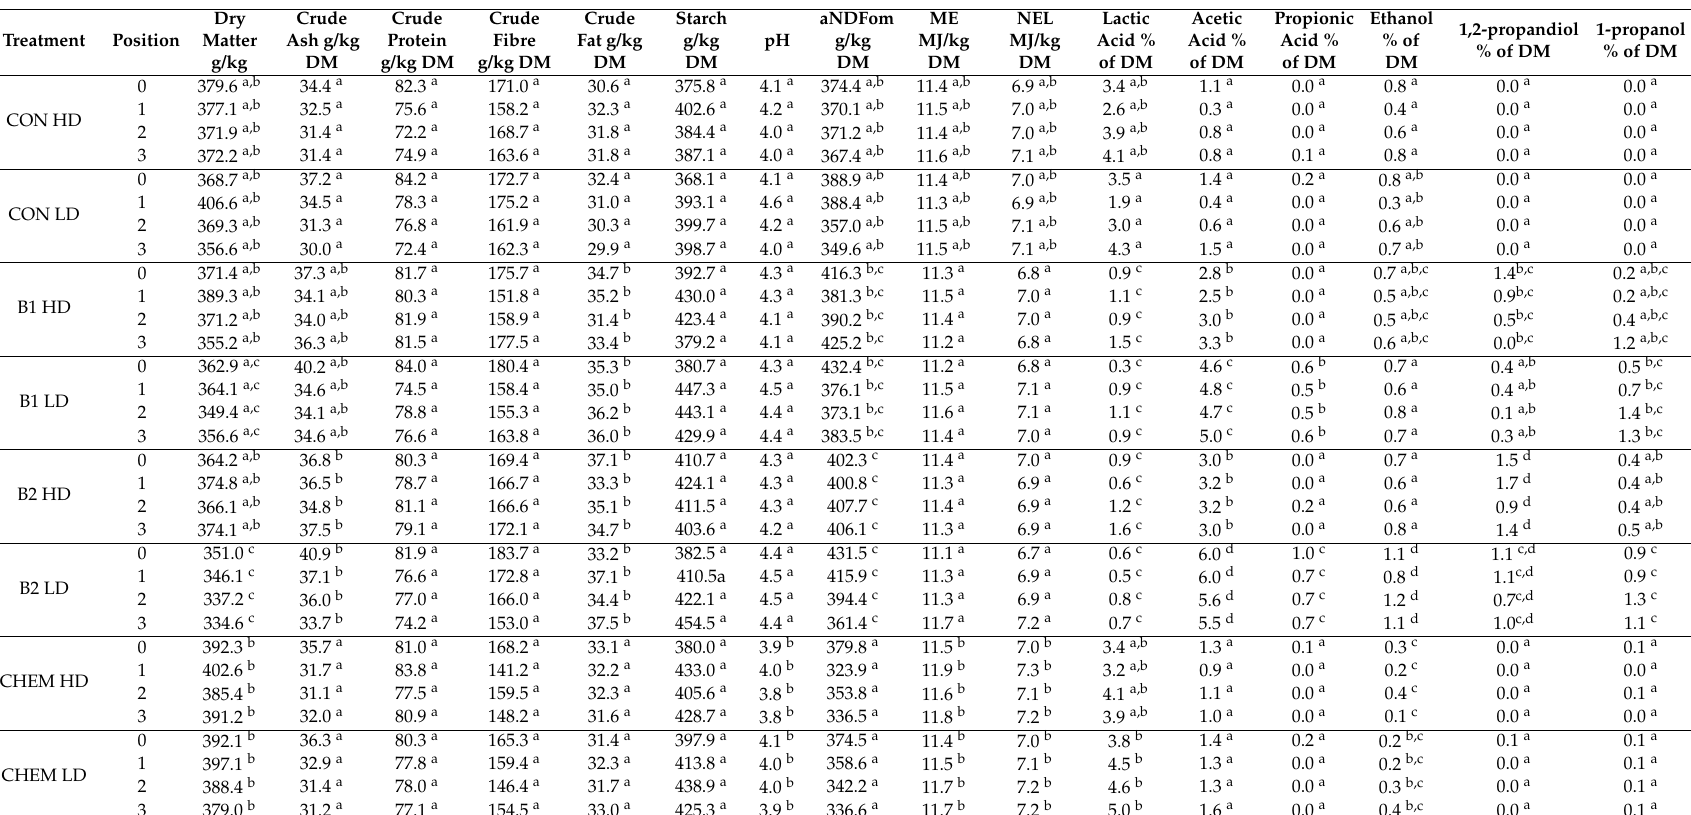
Table 1. Analytical state of maize silage samples from the buckets before (sample 0) and after reheating for silage originating from three different sampling depth as described in Jungbluth et al. (2016) (samples 2–4); DM = dry matter, aNDFom = neutral detergent fibre assayed with a heat-stable amylase and expressed exclusive of residual ash, ME = metabolisable energy, NEL = net energy lactation; a,b Mean values within columns having different superscripts differ ( p <